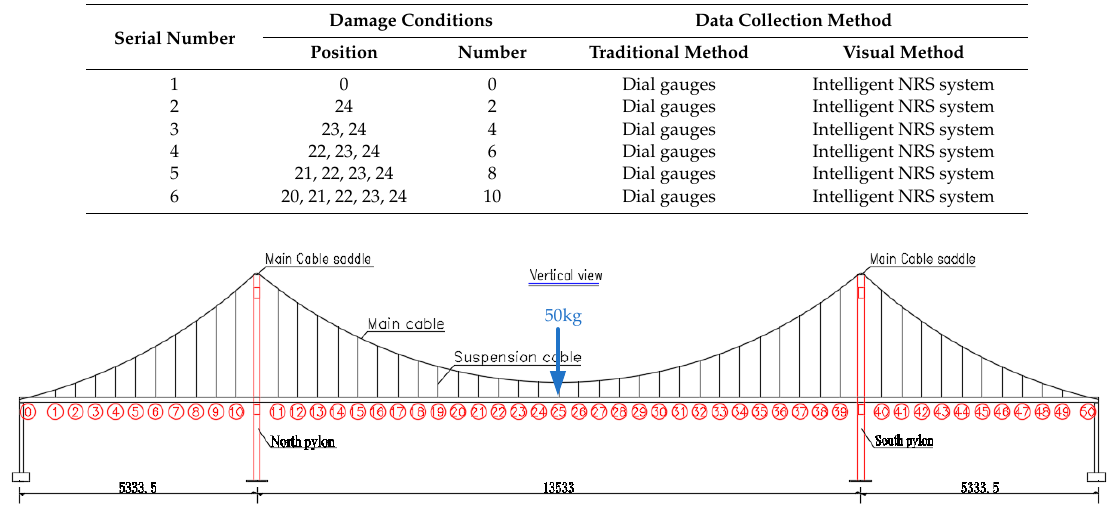
Figure 10. Serial number of suspension cables. Table 1. The positions and numbers of damaged suspension cables.